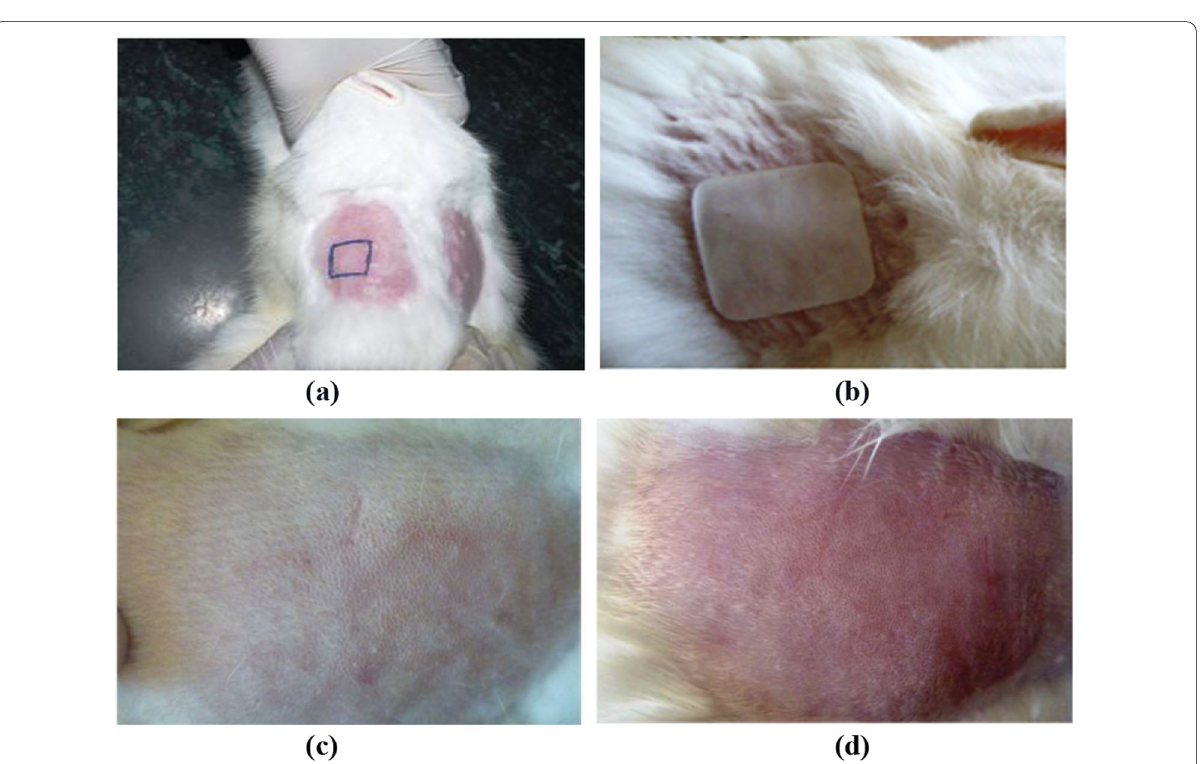
Fig. 9 a Preparation of patch application. b Patch application. c Single use patch after 72 h. d Acute repeated